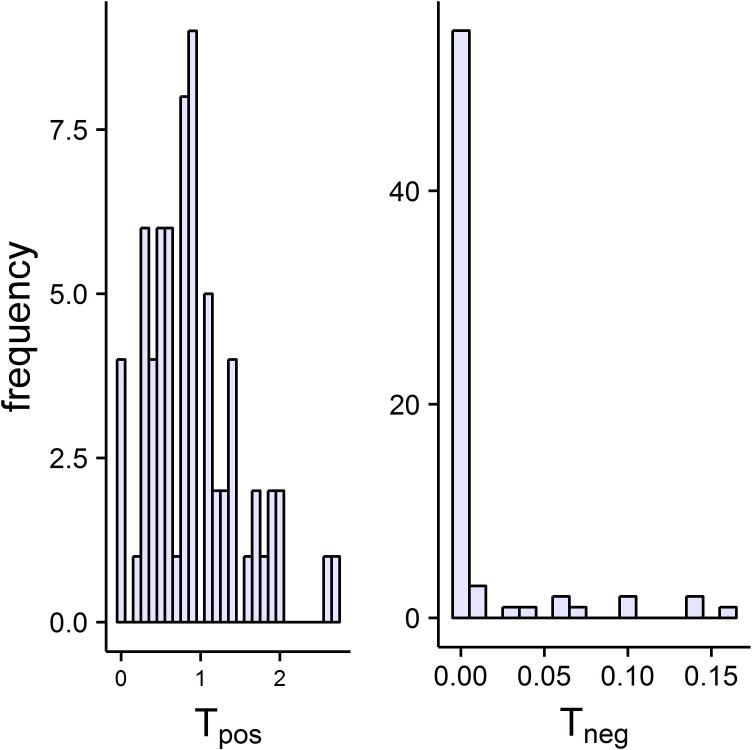
Histograms of Tpos and Tneg for all 68 animals.